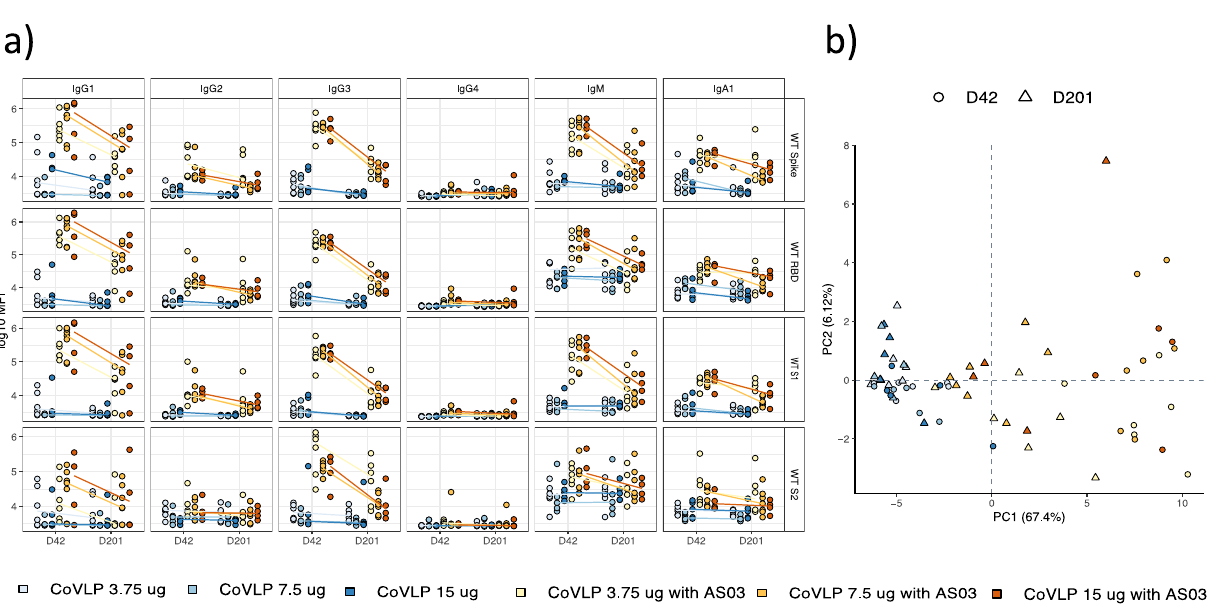
Fig. 1 AS03-adjuvanted CoVLP triggers robust antibody response to wild-type SARS-CoV-2 antigens across different vaccine doses. a The dot plots show the univariate comparisons of WT Spike-speci fi c IgG1, IgG2, IgG3, IgG4, IgM, and IgA across the vaccinees that received different doses (3.75, 7.5, and 15 µg) of CoVLP without AS03 (shades of blue, n = 16) and CoVLP with AS03 (shades of yellow, n = 1 7 ) and at days 42 and 201. Lines connect the median values of groups. b A principal component analysis (PCA) was applied to all samples and data to examine the impact of vaccine dose with and without AS03 adjuvant (different shades of blue and orange) and time since vaccination (day 42 in circles and day 201 in